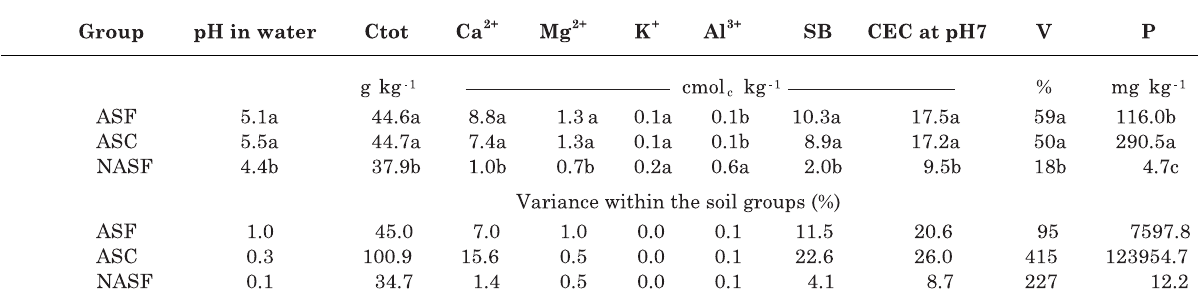
Table 2. Mean values of soil chemical properties and their variance within each soil